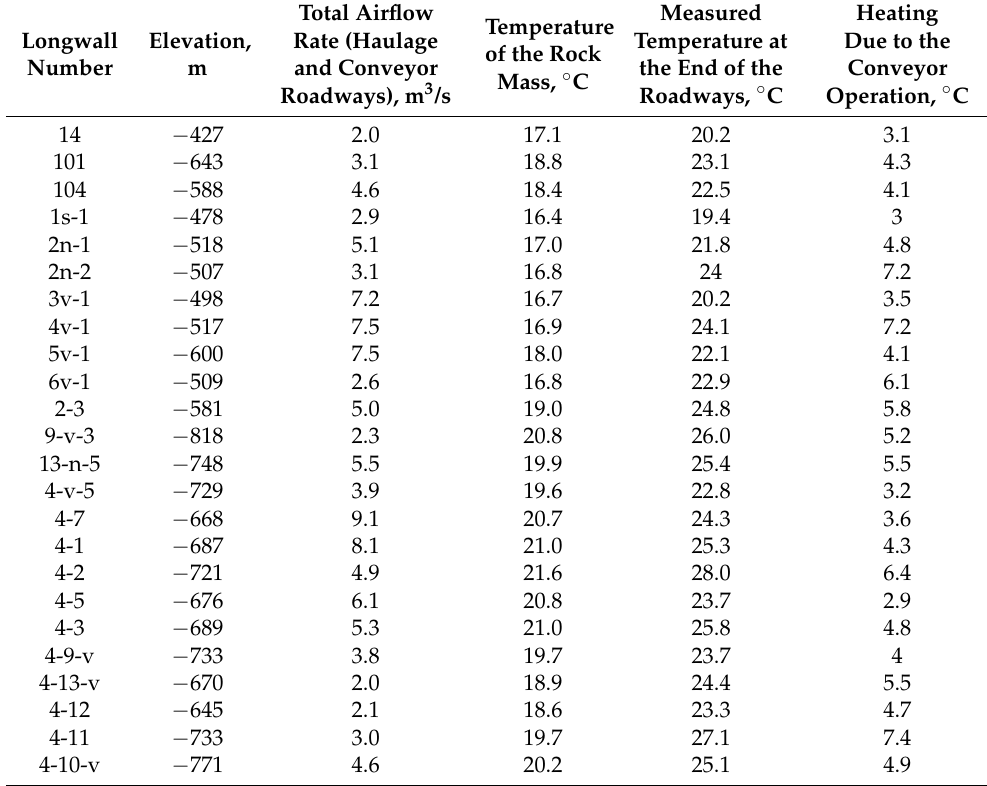
Figure 1. Schematic representation of the air supply along the haulage and transport roadways to a long stope. Table 1. Air temperature measurements at the end of the conveyor roadway.